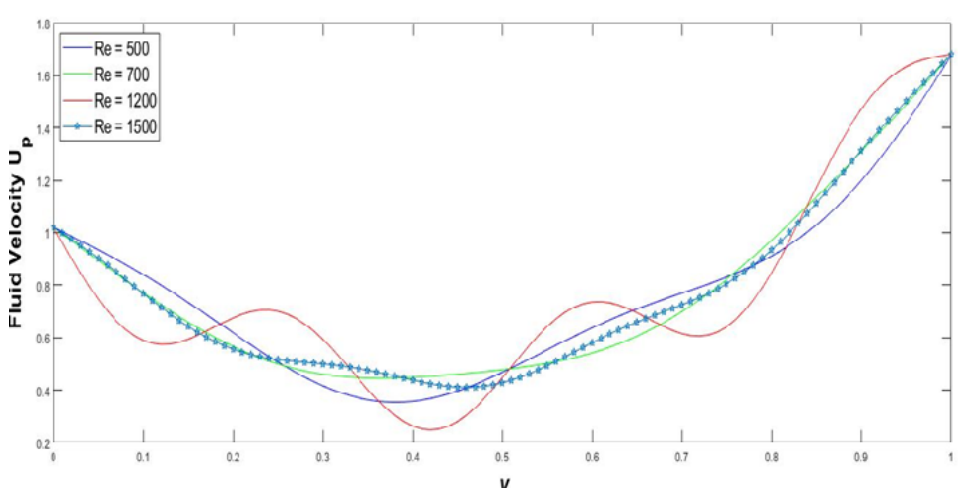
Figure 6. Velocity field for various Reynolds numbers.